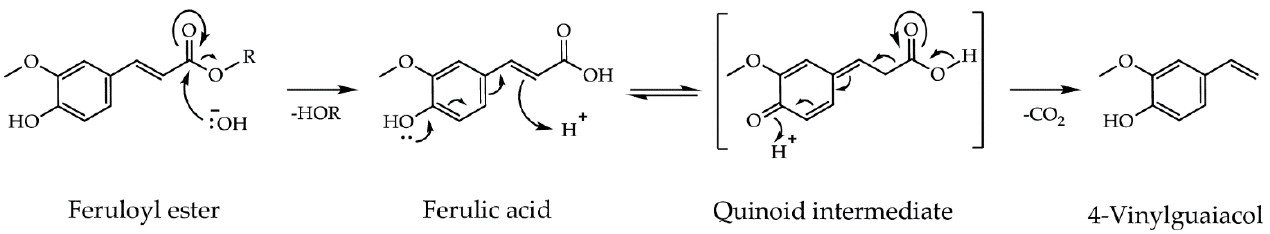
Figure 1. Reaction scheme of the hydrolysis of feruloyl esters to ferulic acid and subsequent decarboxylation via a quinoid intermediate and release of carbon dioxide to form 4-vinylguaiacol [15].